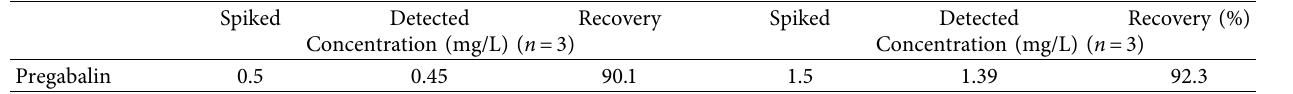
Table 1: Quantitative parameter of PME.